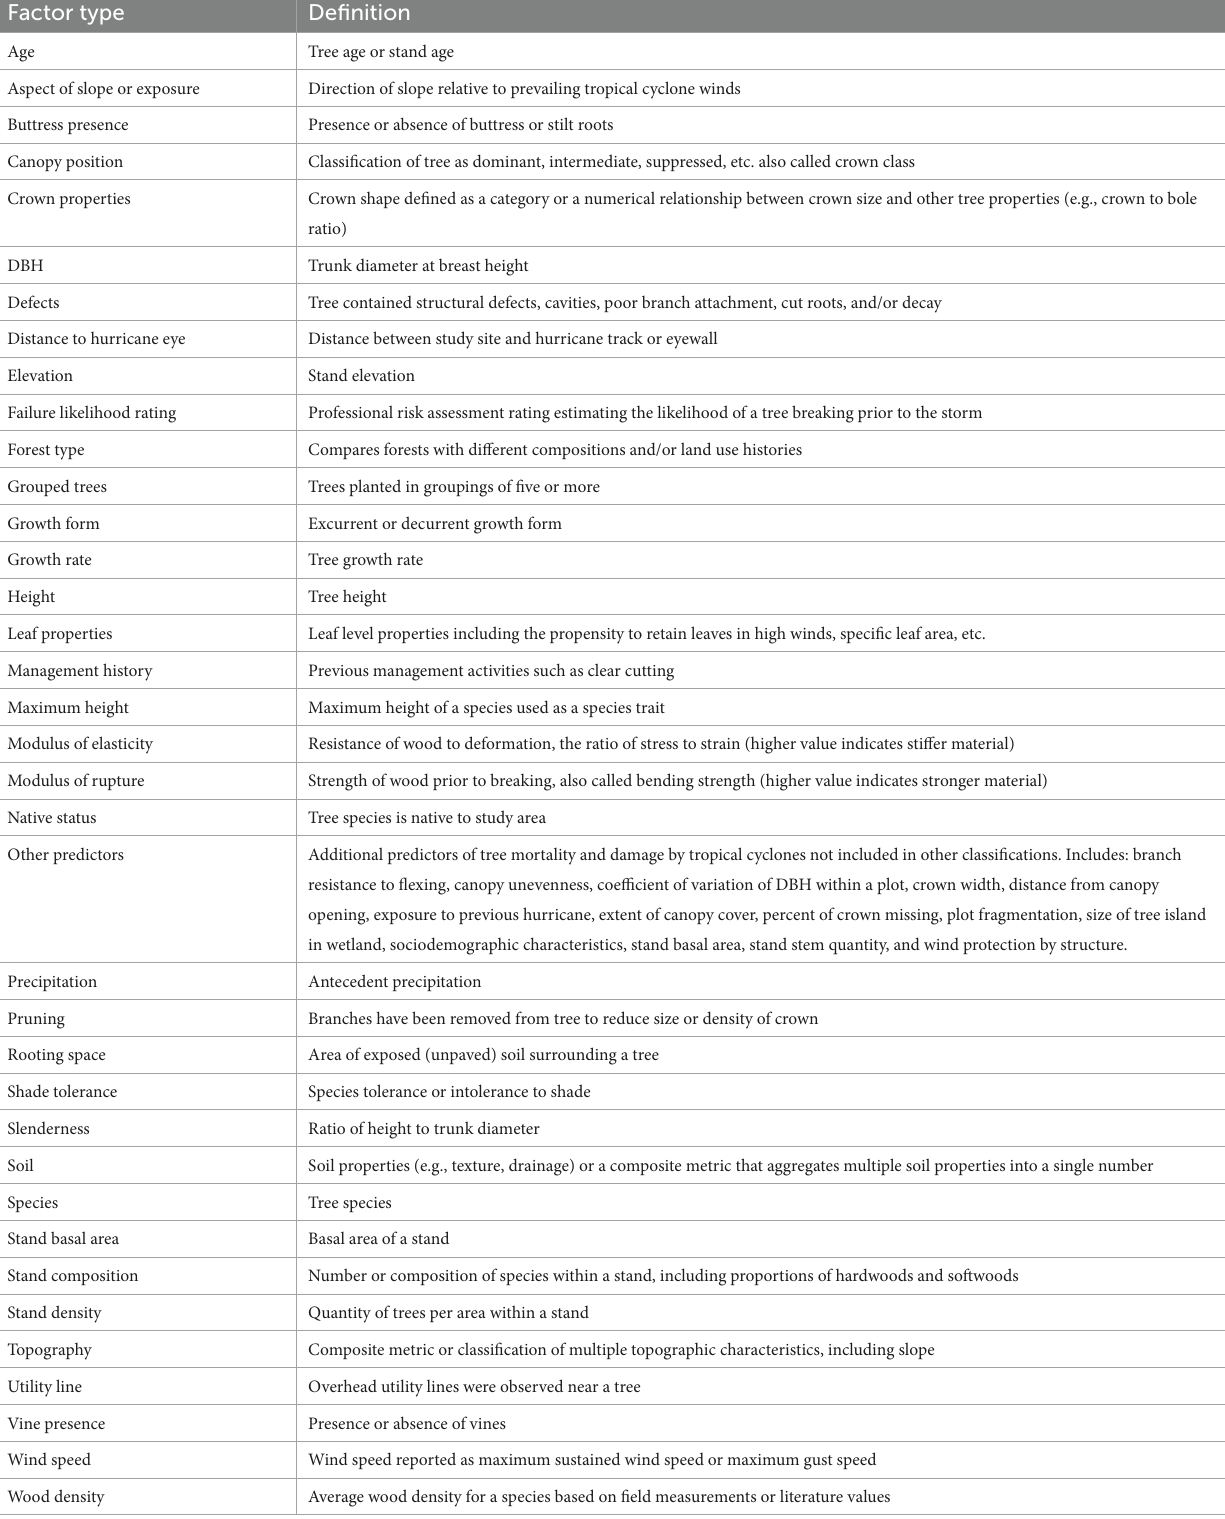
TABLE 2 Types and definitions of factors that affect tropical cyclone damage to trees identified in the literature